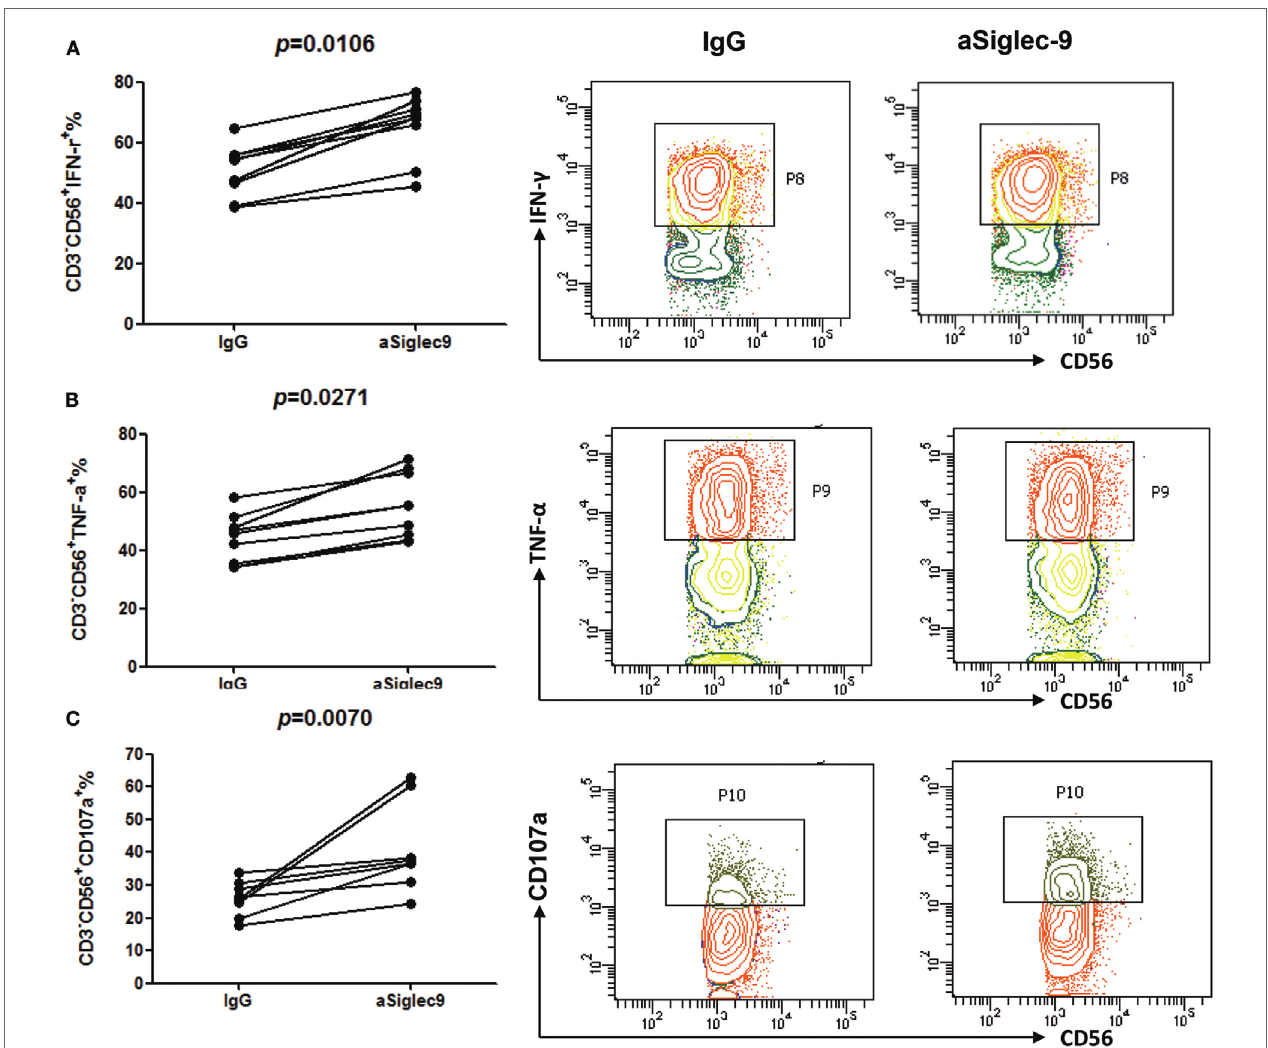
FigUre 5 | Siglec-9 blockade restores cytokine secretion and degranulation of NK cells in chronic hepatitis B (CHB) patients. PBMCs from CHB patients pretreated with Siglec-9 blocking antibody or isotype control IgG were stimulated with PMA plus ionomycin. Then, the expression of IFN- γ (a) , TNF- α (B) , and CD107a (c) were analyzed by flow cytometry. The right panels showed the representative flow cytometry data from one